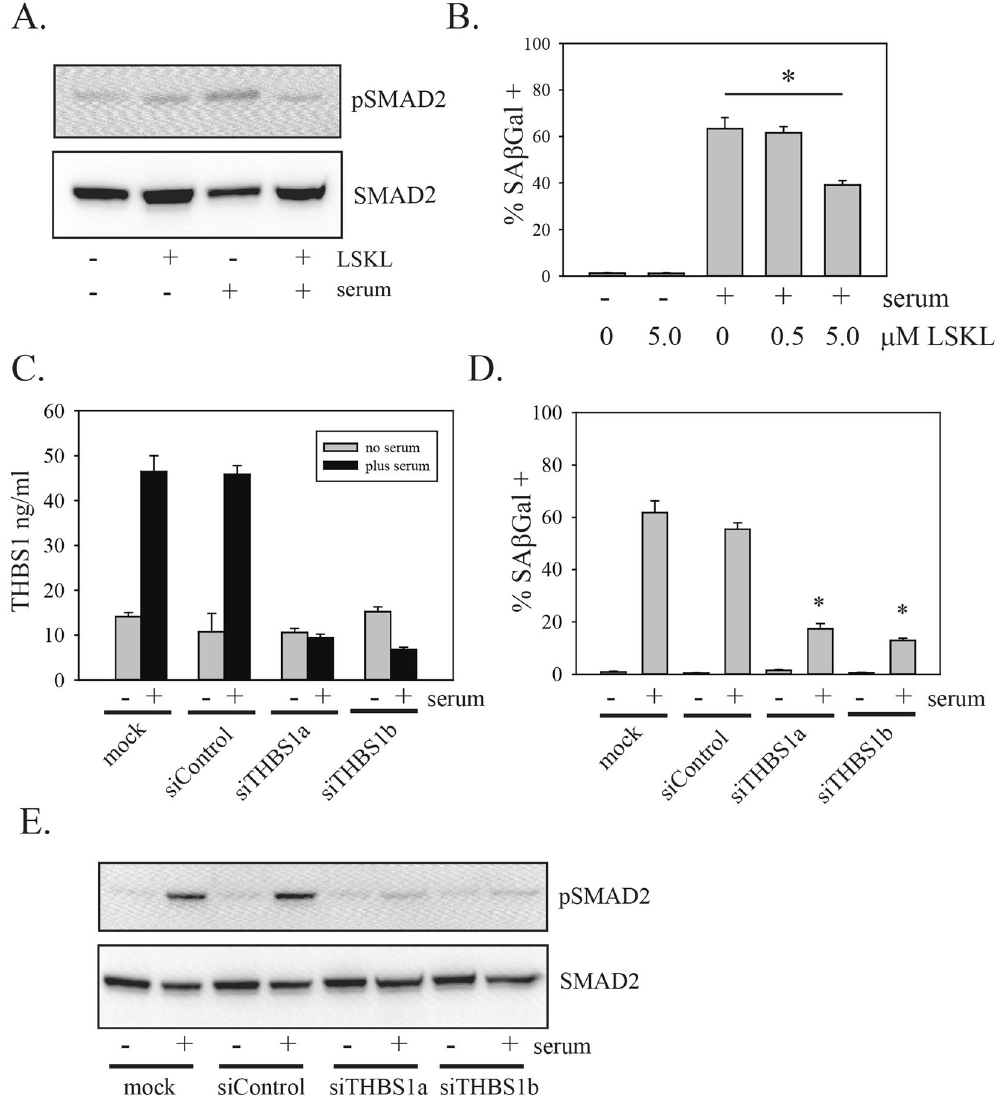
Figure 6. Thrombospondin is required for activation of the TGF β pathway by serum. ( A ) PriGO8A cells were pretreated for 1 h without or with the thrombospondin inhibitor peptide LSKL as indicated. Cells were then treated with media without or with 10% serum for one hour. Total cell lysates were analyzed for phosphorylated and total SMAD2 levels by Western blotting. Representative results from one of three independent experiments are shown. ( B ) PriGO8A cells were treated with or without serum plus the indicated concentrations of LSKL peptide. Media with or without peptide was replaced every two days and SA β gal activity was determined after seven days. ( C ) PriGO8A cells were mock transfected, or transfected with control siRNA or two different siRNA targeting thrombospondin 1. 48 h after transfection, media was removed and replaced with media either without or with serum. Conditioned media samples were collected after 24 h and assayed for thrombospondin levels by ELISA. (D) PriGO8A cells were transfected as in ( C ) Two days later cells were treated without or with serum as indicated. SA β gal assays were performed 7 days after the initiation of serum treatment. ( E ) PriGO8A cells were transfected as in ( C ) 48 h later media was removed and replaced with fresh media without or with serum. One hour later total cell lysates were collected and analyzed for phosphorylated and total SMAD2 by Western